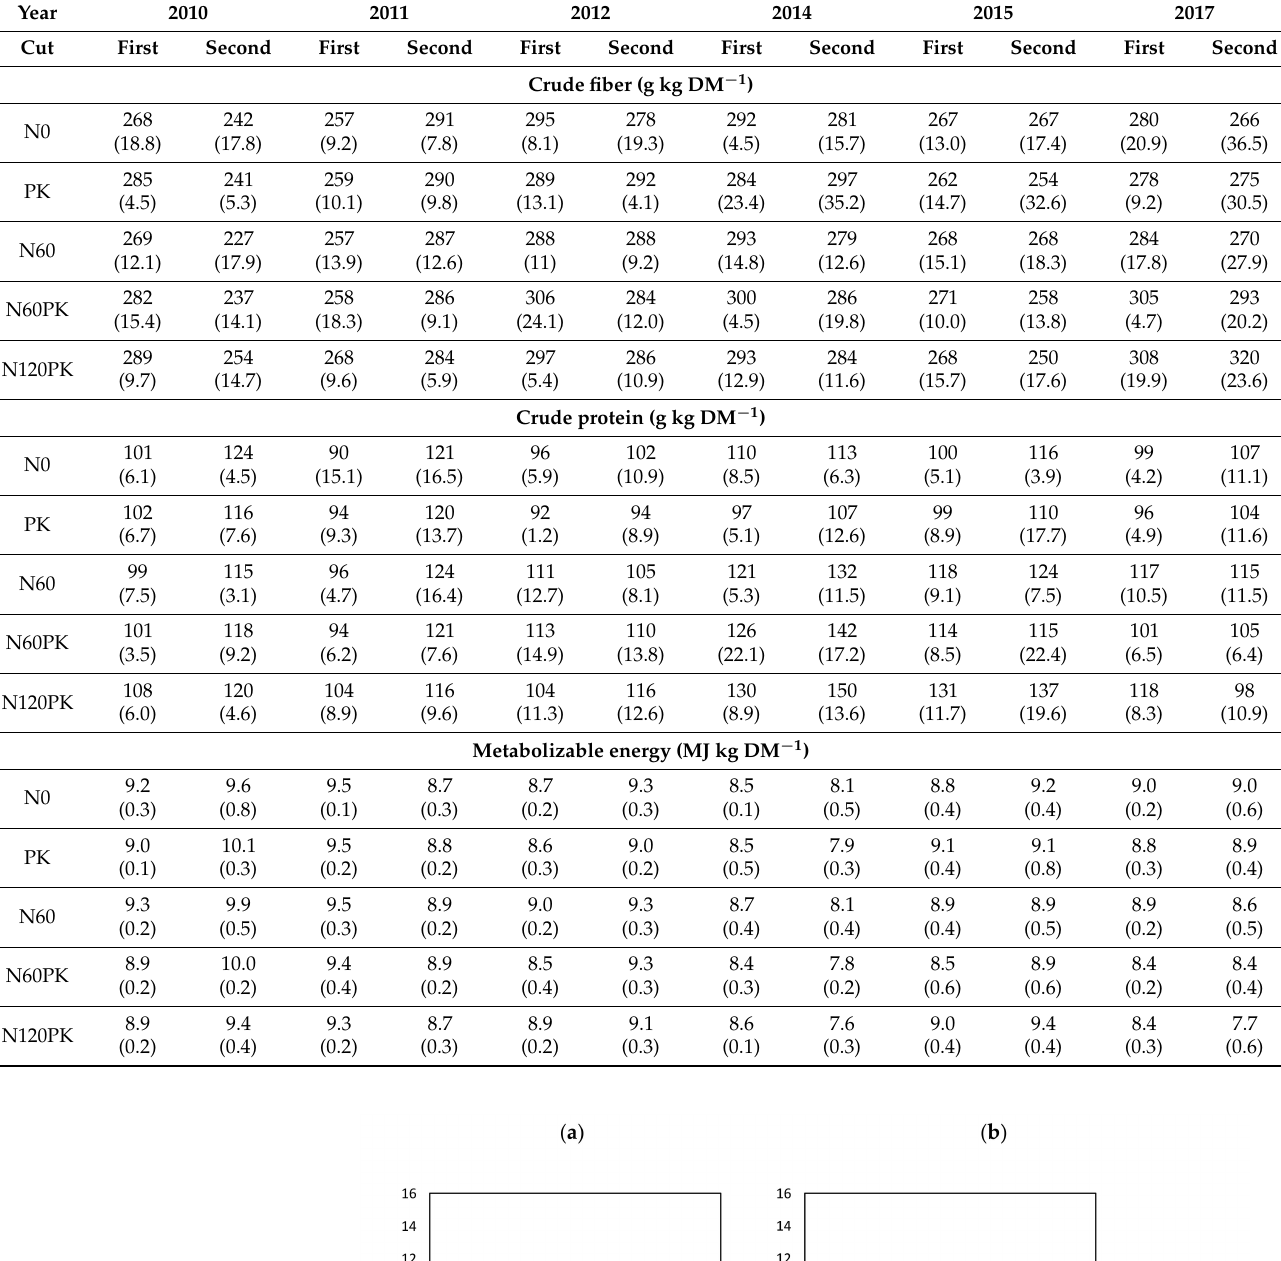
Table A1. Means values and standard deviation (in brackets) of crude fiber (g kg DM − 1 ), crude protein (g kg DM − 1 ) and metabolizable energy (MJ kg DM − 1 ).